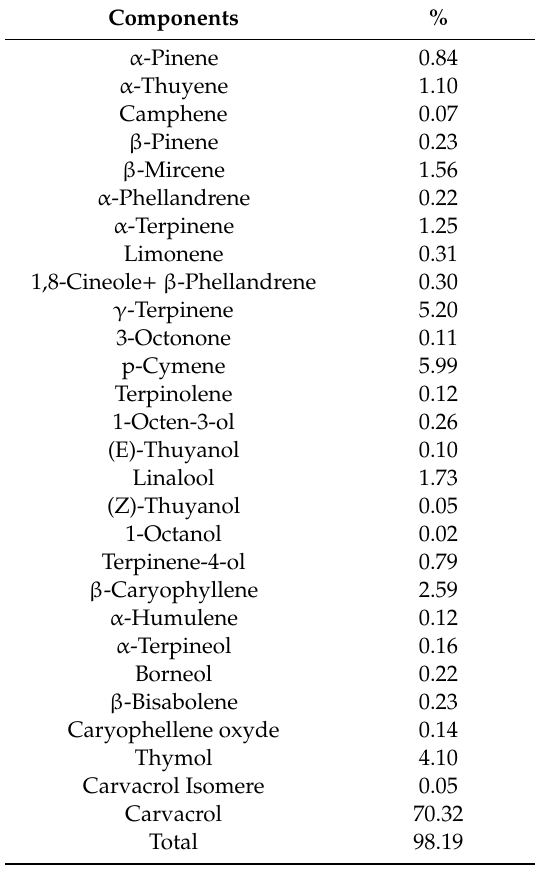
Table 1. Bioactive components of the oregano essential oil